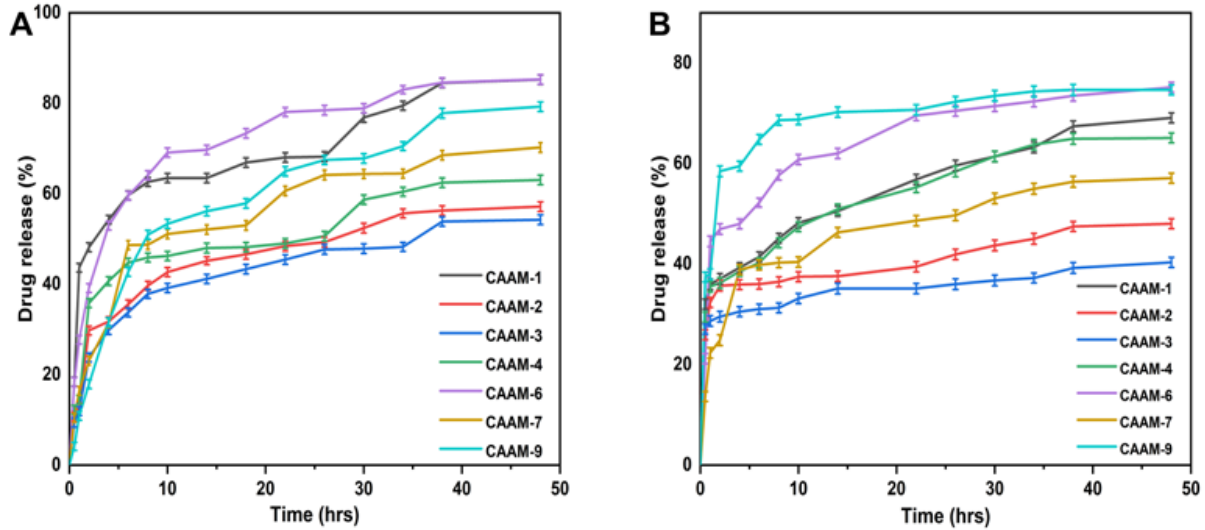
Figure 6. Drug release curves of CS- g -AMPS hydrogels at pH 1.2 ( A ) and pH 7.4 ( B ).